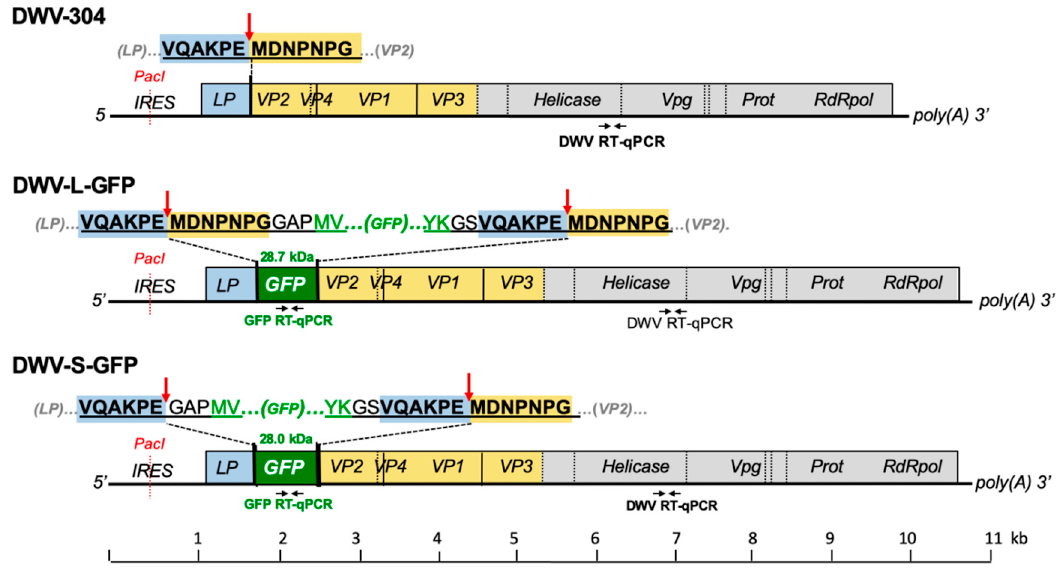
Figure 1. Design of the green fluorescent protein (GFP)-tagged cDNA clones of Deformed wing virus (DWV). Sequences of the peptide linking LP-VP2 and the GFP-flanking peptides are shown above the genetic maps. Arrows indicate the tentative cleavage peptides targeted by the DWV 3C protease, underscored are DWV-derived peptides. Positions of the DWV- and GFP-specific RT-qPCR primers are indicated. DWV, deformed wing virus; LP, leader protein; GFP, green fluorescent protein; Prot, viral 3C protease; RdRpol, RNA-dependent RNA polymerase; RT-PCR, reverse-transcription PCR; VP, structural viral protein; Vpg, genome-linked protein.